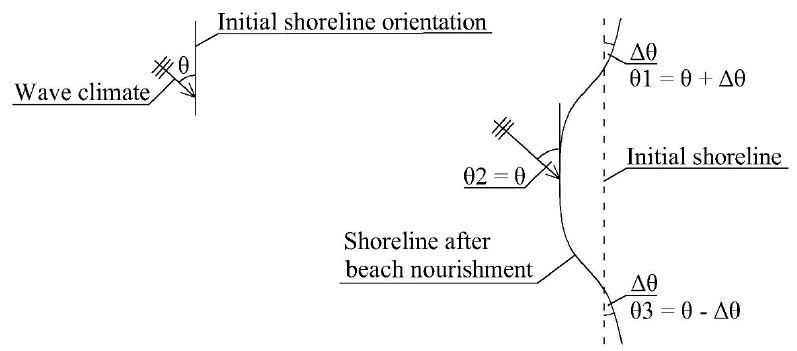
Figure 2. Wave angles before ( θ ) and after sand nourishment ( θ 1, θ 2, and θ 3, respectively, at updrift, middle, and downdrift of the intervention limits).